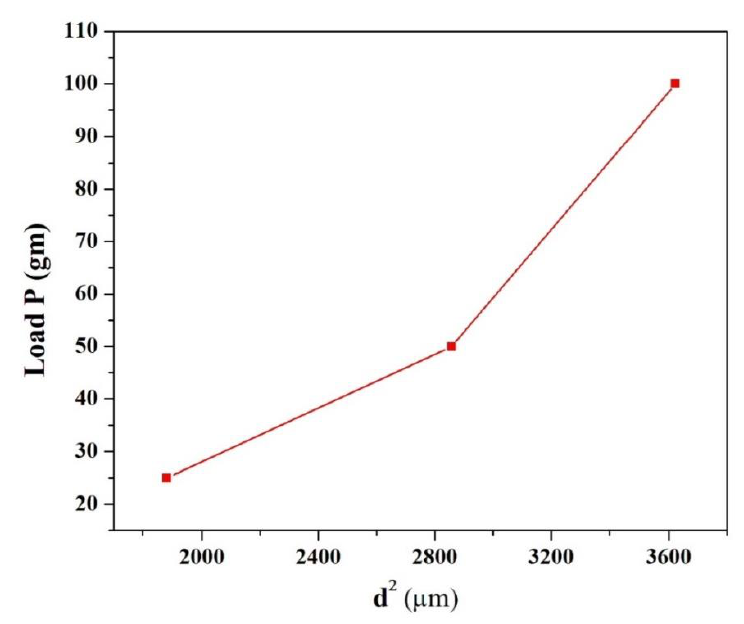
Figure 13. Variation of d 2 versus Load P for UGA.